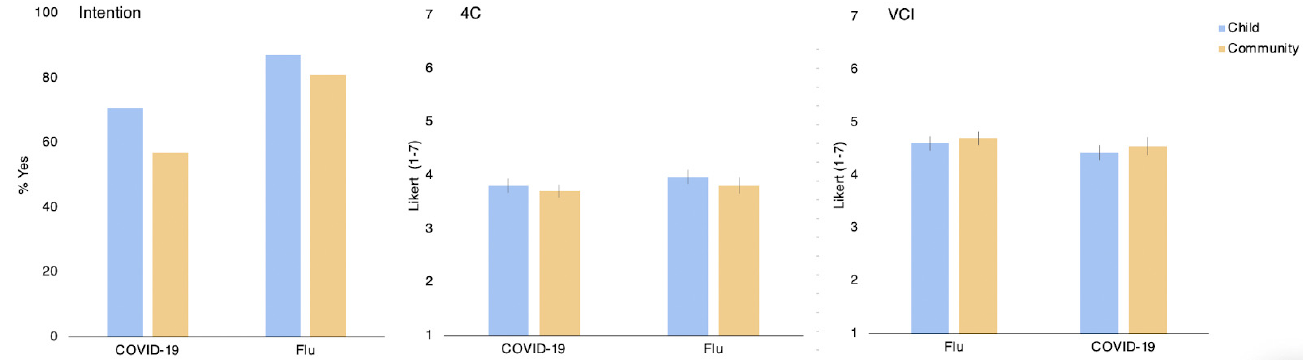
Figure 3. The effect of type of risk frame (child vs. community) by type of disease (Flu vs. COVID-19) discussed on vaccination intention ( left ) and attitude (4C middle , VCI right ). Error bars display 95% Confidence Intervals.